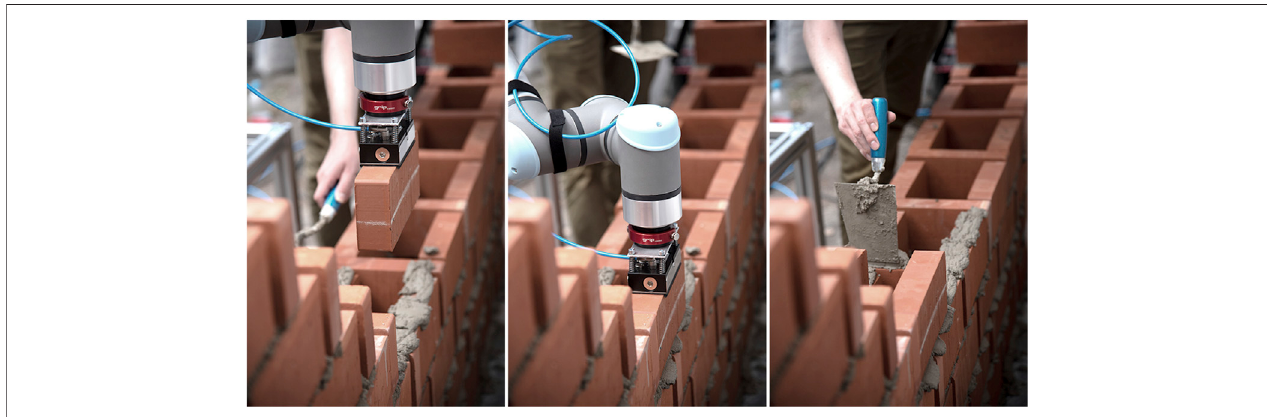
FIGURE 8 | Craftitude meets robotic fabrication: While a person mixes and applies the mortar, the collaborative robot lays individual bricks according to the digital model. Theconsistencyofthefreshmortar allowstherobottoeasilypress thebrickintoplace,after whichthepersoncanremove anyexcessmortar andgroutthejoint.